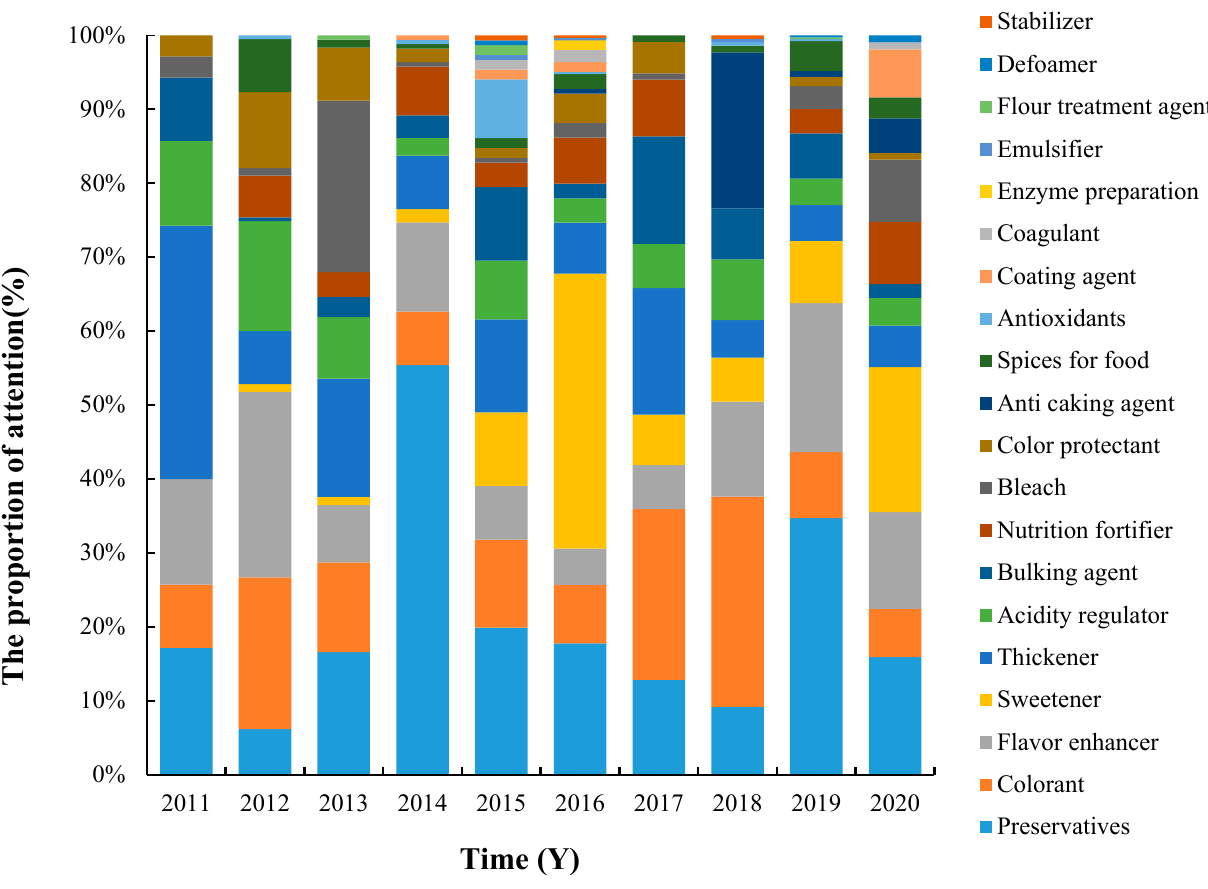
Figure 1. Consumers’ attention to various food additives from 2011 to 2020.